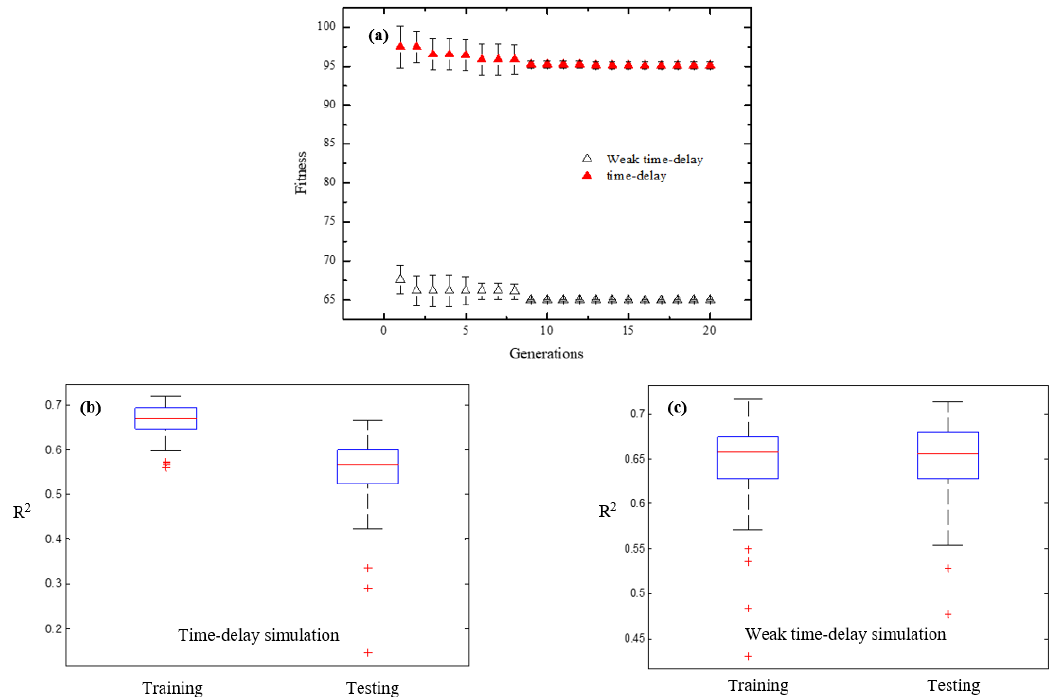
Figure 9. ( a ) The fitness of particles affected by the time-delay data and the weak time signals by